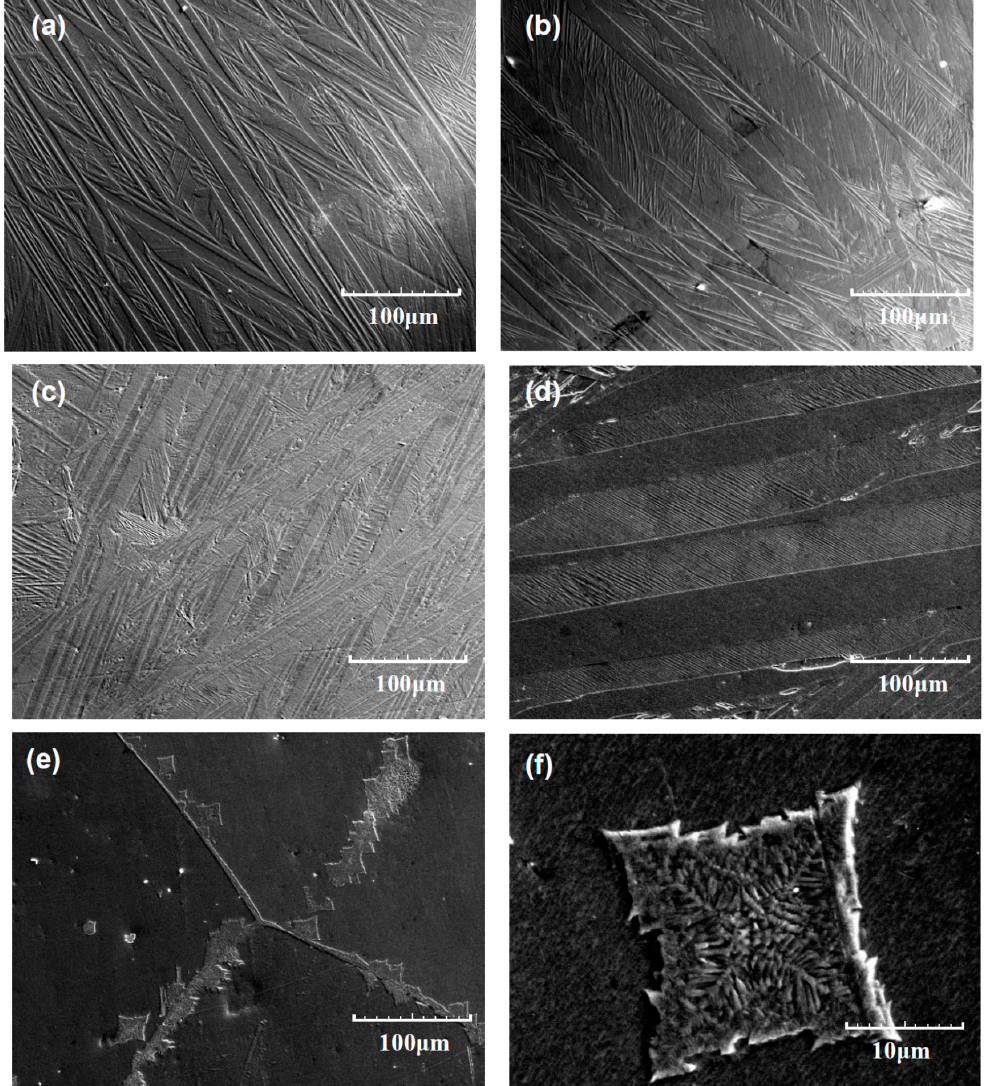
Figure 2. SEM images of ( a ) Cu-7.0Zn-11Al, ( b ) Cu-7.5Zn-11Al, ( c ) Cu-8.0Zn-11Al, ( d ) Cu-8.5Zn-11Al, and ( e ) Cu-9.0Zn-11Al SMAs under the same magnification. ( f ) A magnified SEM image of ( e ).